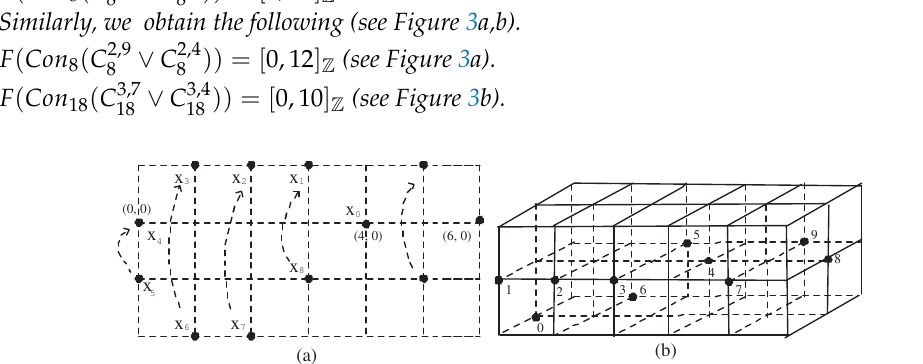
( C 3,7 ∨ C 3,4 )) = [ 0,10 ] Z 18 18 18